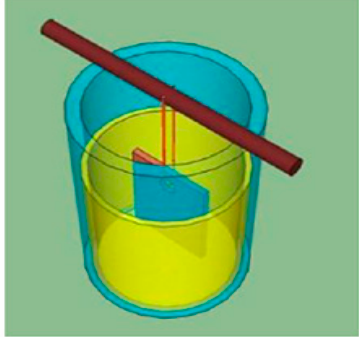
Figure 1. Schematic diagram for immersion test [1].